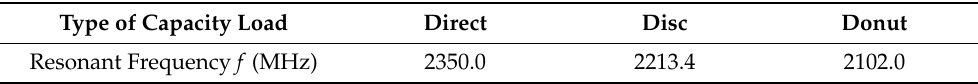
Table 1. Relationship between loading mode and resonant frequency.